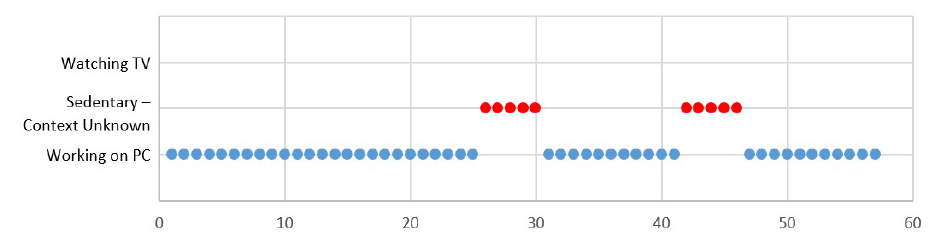
Figure 17. Misrecognized context while working on a